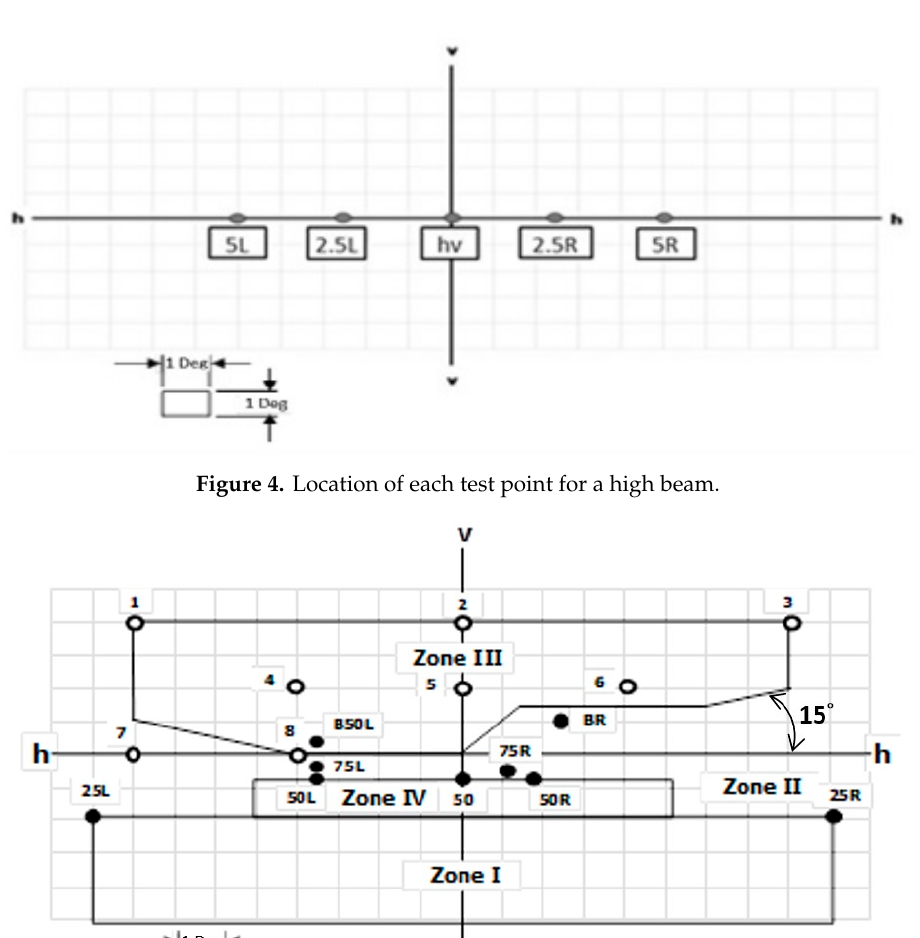
Figure 3. Three-dimensional view of the freeform lens. Please take note that curvature of X-axis and Y axis on this surface is different so that their optical power and ray-bending varies. This freeform is simply a sample, not the freeform employed in proposed optical design in this paper. The 3D drawing of freeform of optical design proposed in this paper is subject to limited drawing capabilities of LightTools for academic.